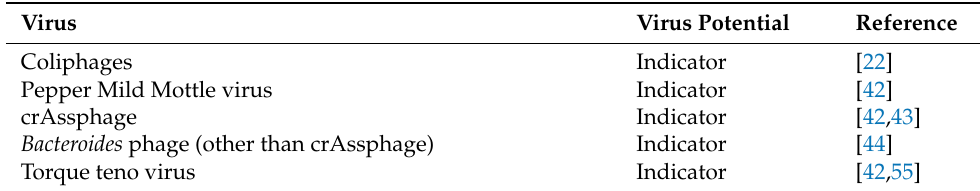
Table 1. Examples of viral family/species/types detected in water, soil, foodstuff, and air using viral metagenomics. Table highlights those viruses with indicator potential or potential pathogenic/ health